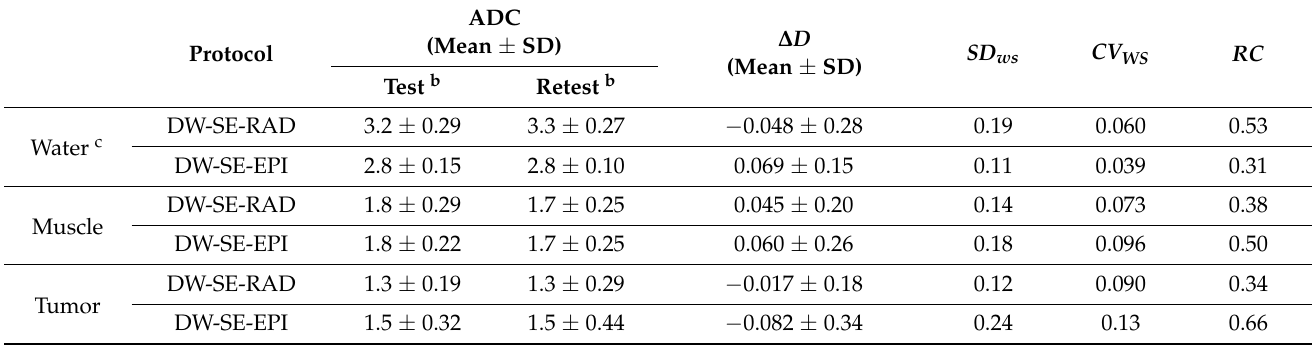
Table 1. Statistical parameters derived from the apparent diffusion coefficient (ADC) estimates in the test–retest study a .